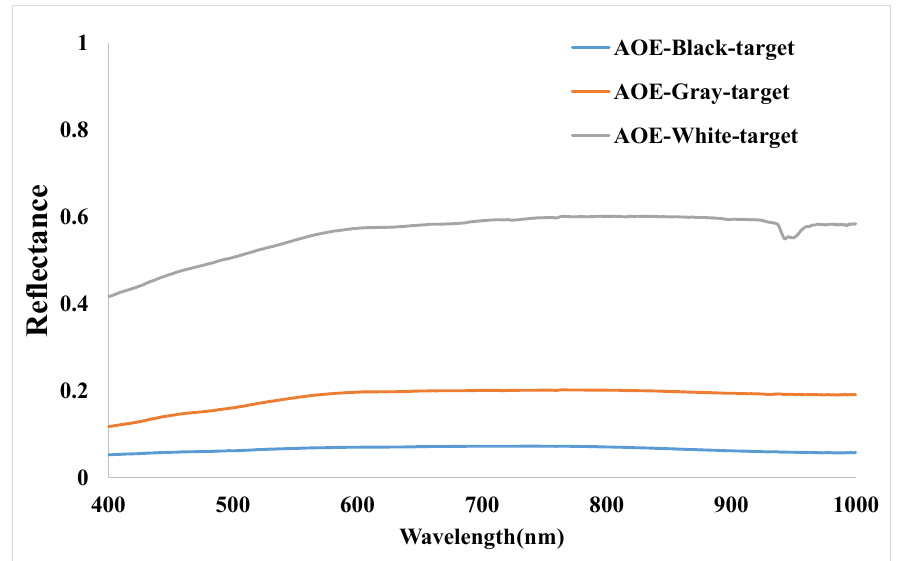
Figure 6. Spectral reflectance measurement data of gray-scale permanent targets.